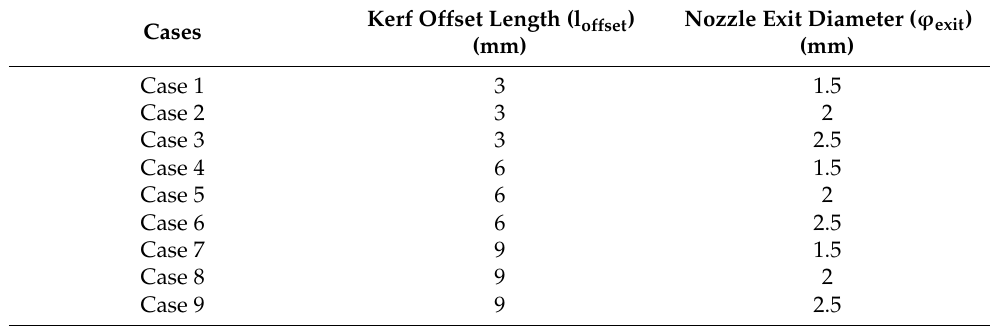
Table 1. Simulation cases with different kerf and nozzle